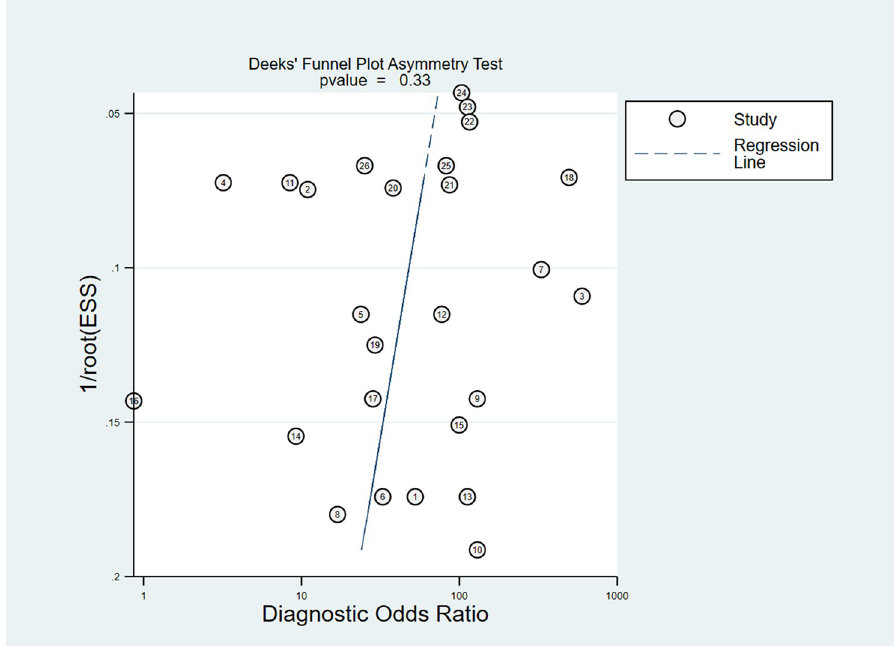
Fig 8. Publication bias in AI-assisted diagnosis of lung